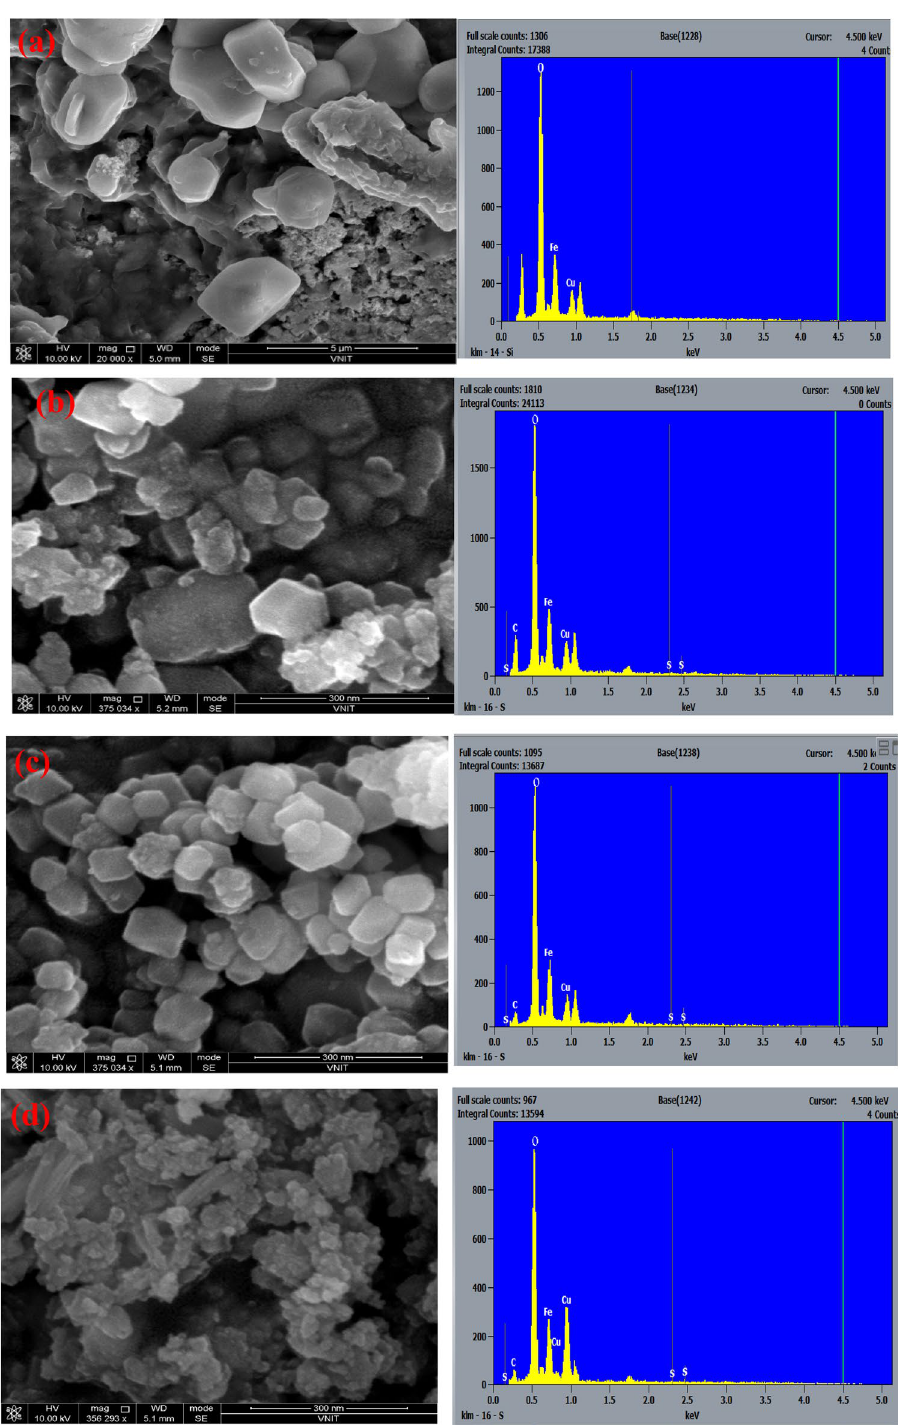
Figure 2. SEM image of ( a ) CuFe 2 O 4 ( b ) 1-Th/CuFe 2 O 4 ( c ) 3-PTh/CuFe 2 O 4 ( d ) 5-PTh/CuFe 2 O 4